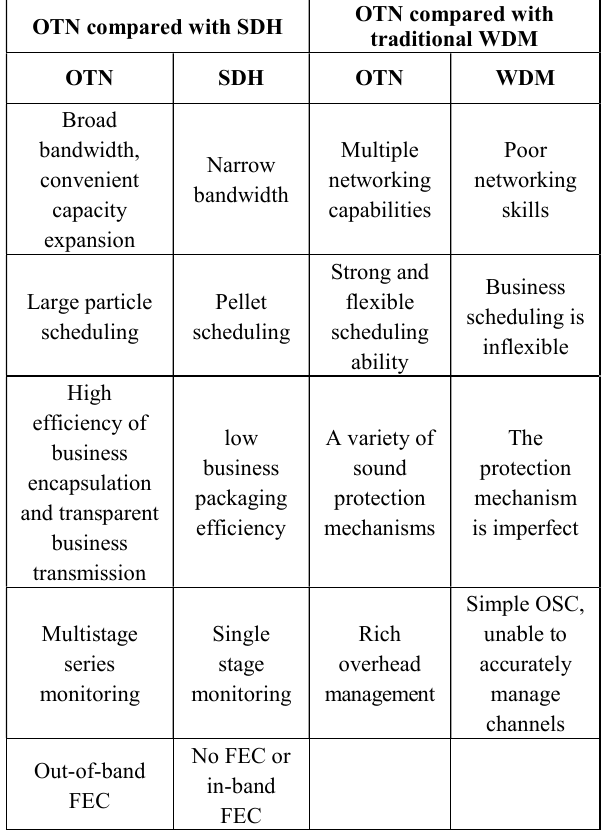
Table 1. Comparison of OTN, SDH and WDM Carrying schemes OTN compared with